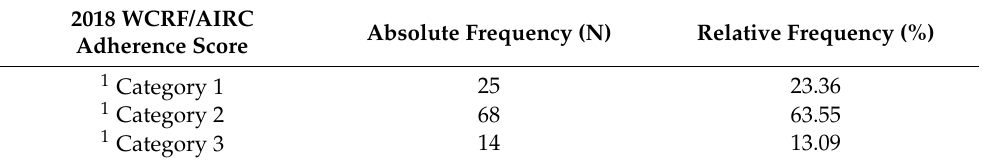
Table 2. Distribution at baseline of the 107 DAMA25 study participants according to the 2018 WCRF/AICR adherence score in categories.